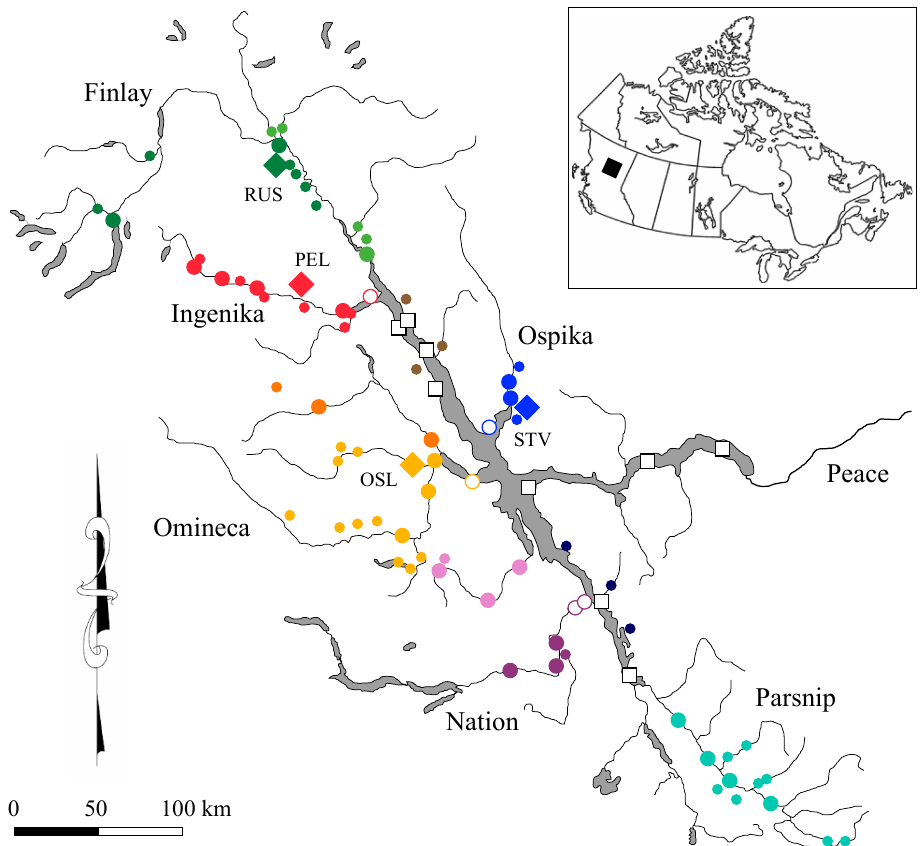
Figure 1. Sampling sites in the Williston Reservoir watershed where water samples and mature Kokanee spawners were collected. Water sampling sites are indicated as large, closed circles from mainstem rivers, small, closed circles from tributary streams, open large circles from embayments with color defining the regional groups, and open squares for samples collected from different locations in the reservoir. Locations where Kokanee were collected are shown as solid diamonds: Russel Creek (RUS), Pelly Creek (PEL), Osilinka River (OSL), and Stevenson Creek (STV).